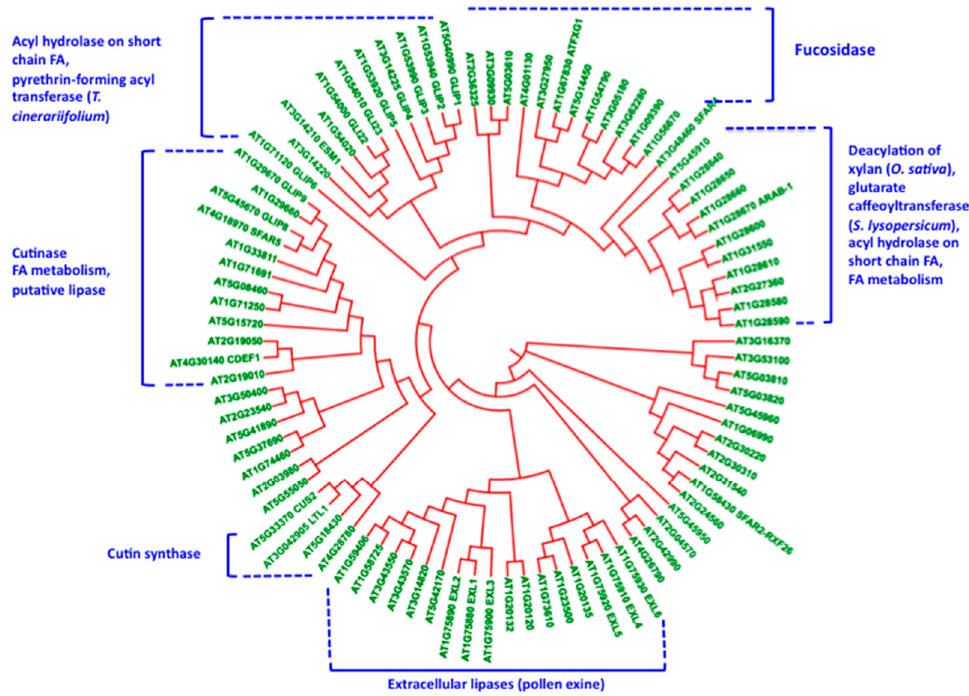
Figure 4. Phylogenetic tree (using the Interactive Tree of Life viewer at https://https://itol.embl.de/) of selected Arabidopsis GDSL-lipases. Clades containing proteins with functional characterization were highlighted. These functions were determined in Arabidopsis and other plant species (rice, tomato, etc.). The Arabidopsis homologs of GDSL-lipases with functional properties characterized in other plant species are presented in the phylogenetic tree.